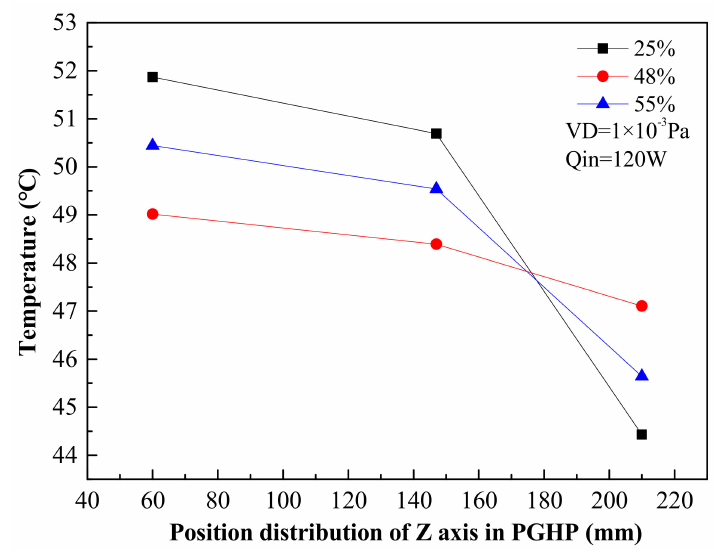
Figure 11. Temperature distribution on the Z-axis of the PGHP at different fluid filing